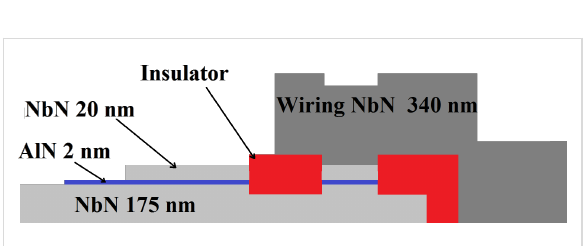
Figure 12: A section of our samples indicating the layers of the fabri- cation steps and their relative